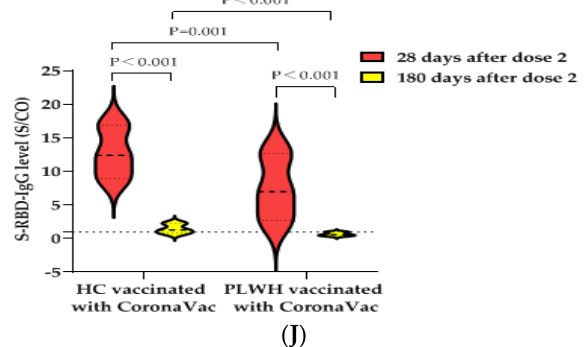
Figure 1. IgG antibody responses and immune persistence of two doses of BBIBP-CorV Vaccine or CoronaVac Vaccine in PLWH and HC . Twenty-six PLWH having CD4 + T cell counts <350 cells/μL were vaccinated with BBIBP-CorV Vaccine (n = 15) or CoronaVac Vaccine (n = 11); one hundred PLWH having CD4 + T cell counts ≥ 350 cells/μL were vaccinated with BBIBP-CorV Vaccine (n = 48) or CoronaVac Vaccine (n = 52); one hundred and thirty HCs were vaccinated with BBIBP-CorV Vaccine (n = 65) or CoronaVac Vaccine (n = 65). Ninety-nine PLWH were vaccinated with BBIBP-CorV Vaccine (n = 49) or CoronaVac Vaccine (n = 50) and completed second blood collection at 180 days after second dose; eighty-three HCs were vaccinated with BBIBP-CorV Vaccine (n = 47) or CoronaVac Vaccine (n = 36) and completed second blood collection at 180 days after second dose. ( A ) The S-RBD-IgG antibody seropositivity rates of PLWH with different CD4 + T cell counts at 28 days after vaccination. ( B ) The S-RBD-IgG antibody levels of PLWH with different CD4 + T cell counts at 28 days after vaccination. ( C ) The S-RBD-IgG antibody seropositivity rates of PLWH having CD4 + T cell counts ≥ 350 cells/μL and HCs at 28 days after vaccination. ( D ) The S-RBD-IgG antibody levels of PLWH having CD4 + T cell counts ≥ 350 cells/μL and HCs at 28 days after vaccination. ( E ) Effects of vaccination with BBIBP-CorV vaccine or CoronaVac vaccine on CD4 + T cell counts of PLWH. ( F ) Effects of vaccination with BBIBP-CorV vaccine or CoronaVac vaccine on VL of PLWH. ( G ) The S-RBD-IgG antibody seropositivity rates of PLWH and HCs vaccination with BBIBP-CorV vaccine at 28 and 180 days after the second dose. ( H ) The S-RBD-IgG antibody levels of PLWH and HCs vaccination with BBIBP-CorV vaccine at 28 and 180 days after the second dose. ( I ) The S-RBD-IgG antibody seropositivity rates of PLWH and HCs vaccination with CoronaVac vaccine at 28 and 180 days after the second dose. ( J ) The S-RBD-IgG antibody levels of PLWH and HCs vaccination with CoronaVac vaccine at 28 and 180 days after the second dose.